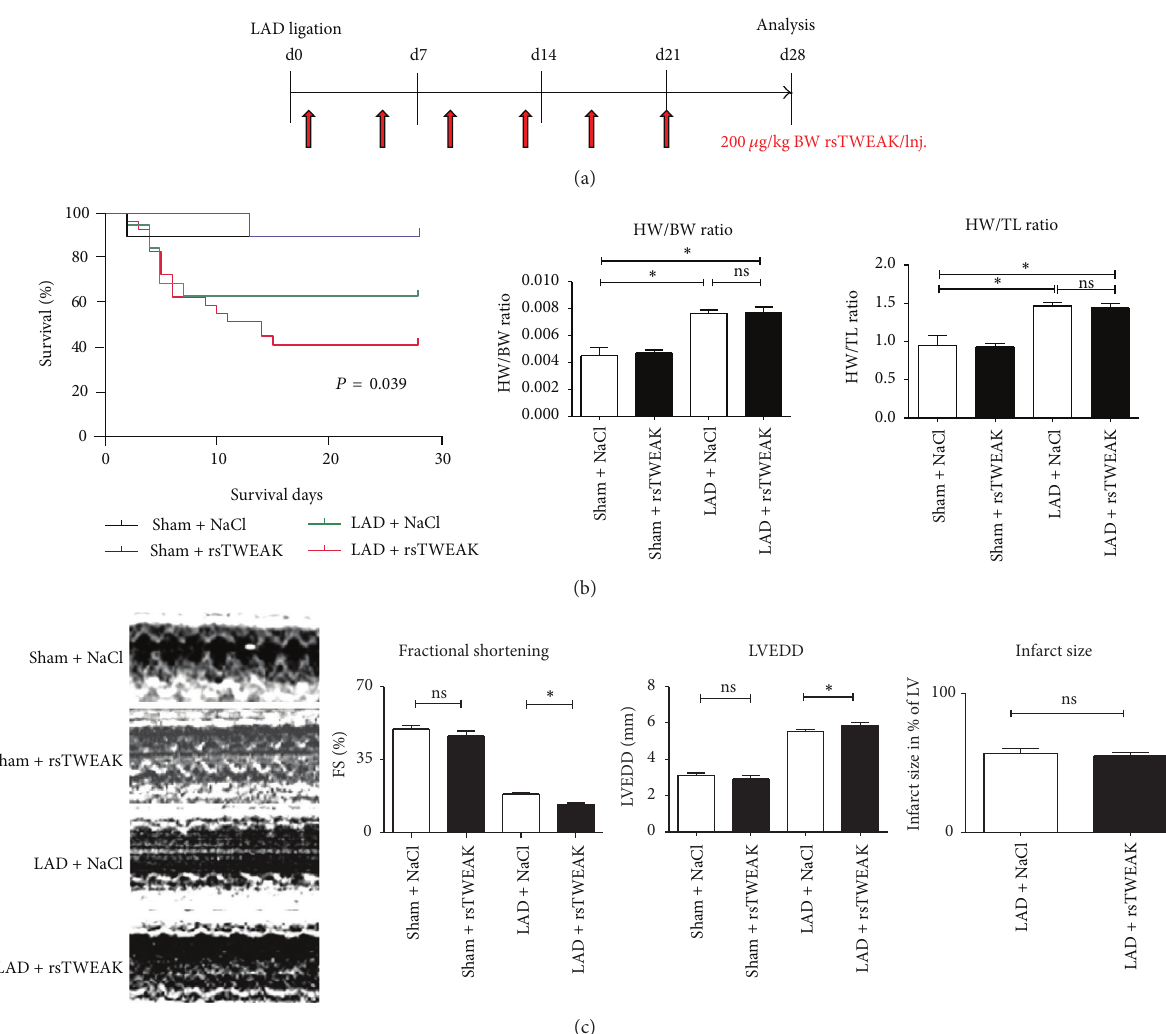
Figure 3: Deleterious effects of recombinant sTWEAK on myocardial function and survival after MI. (a) Recombinant sTWEAK (or vehicle (NaCL)) was injected every 3 days i.p. at a dose of 200 𝜇 g/kg body weight for each injection starting 1 day after induction of myocardial infarction in mice. (b) Treatment of mice with recombinant sTWEAK for 28 days resulted in significantly increased mortality after myocardial infarction compared to control animals ( 𝑃 = 0.039 sTWEAK versus NaCL). No changes in the degree of myocardial hypertrophy could be observed. (c) Echocardiographic analysis revealed reduced left ventricular function and increased left ventricular end-diastolic diameters (LVEDD) (both 𝑃 < 0.05 ; sham + NaCL 𝑛 = 4 ; sham + rsTWEAK 𝑛 = 6 ; LAD + NaCL 𝑛 = 12 ; LAD + rsTWEAK 𝑛 = 20